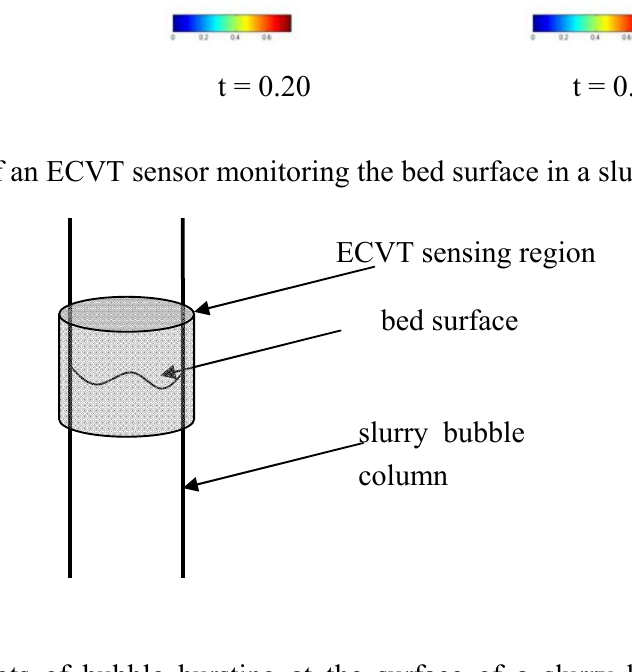
Figure 18. Snapshots of bubble bursting at the surface of a slurry bubble column by ECVT: (a) 3D image before bubble bursting; (b) 3D image after bubble